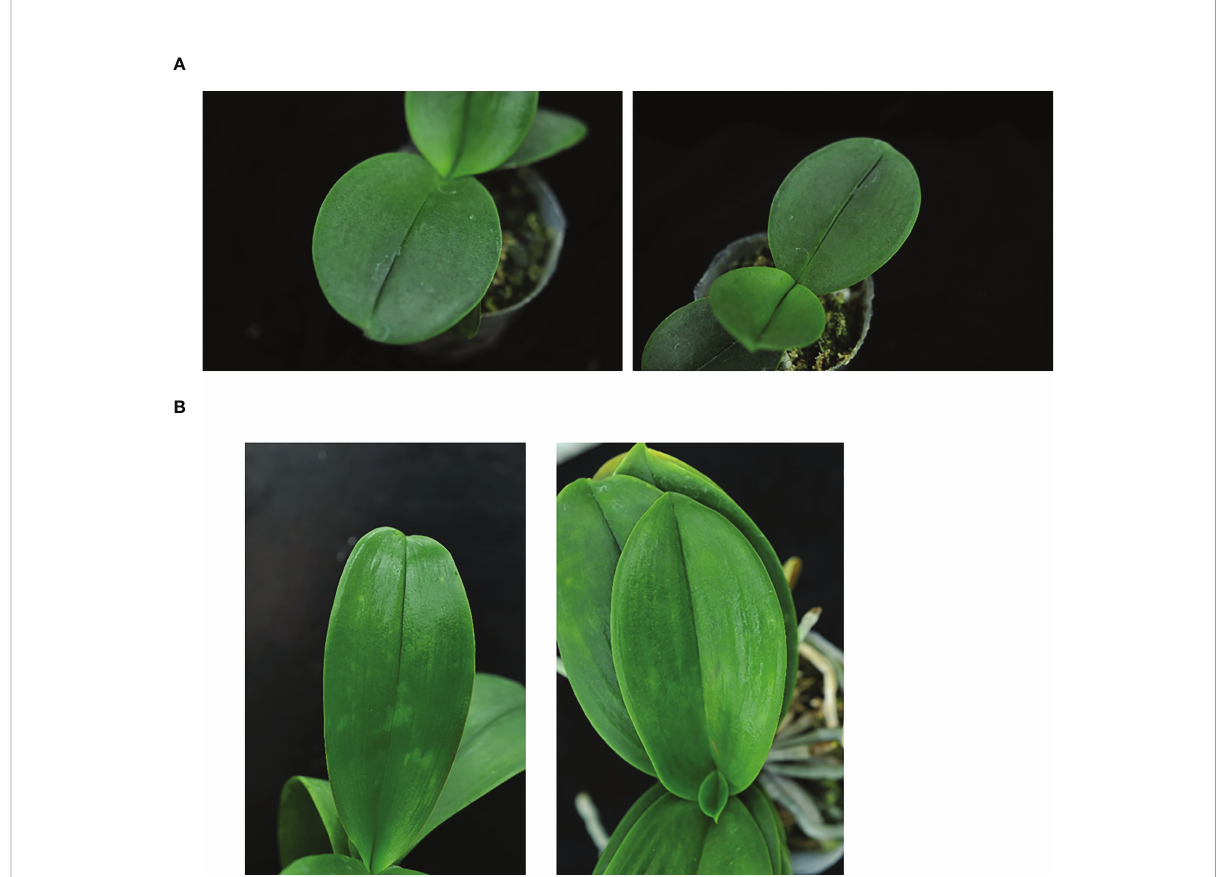
TABLE 6 The accuracy comparison between the proposed two-stage model and expert identi fi cations for the CymMV and ORSV categories.